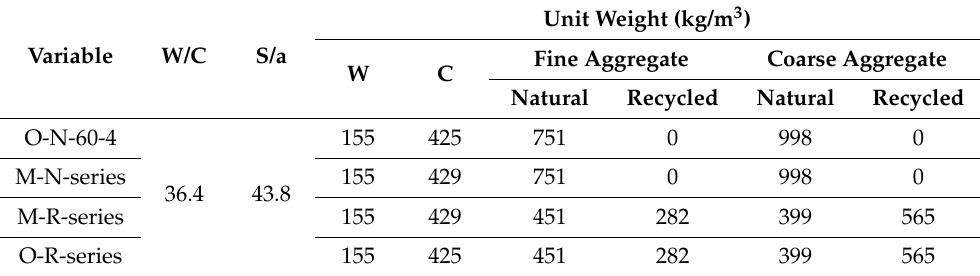
Figure 2. Particle size distribution curve for ( a ) coarse aggregates, and ( b ) fine aggregates. Table 2. Mixture proportions (all quantities in kg/m 3 unless specified